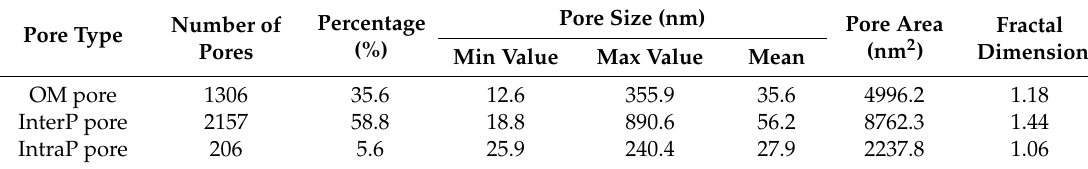
Table 2. Image processing results of representative elementary area (REA) for the Shahezi shale in CFD.